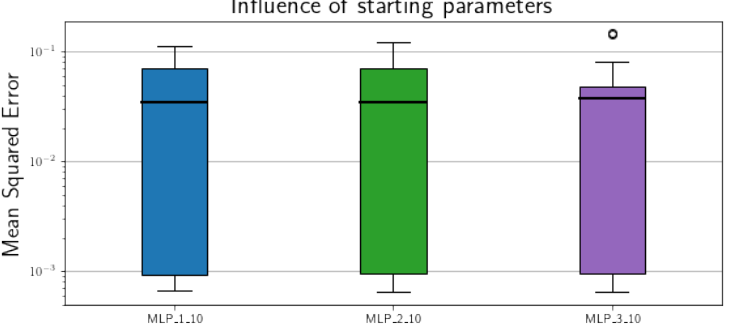
Figure 9. Limits and confidence intervals of the results of the MSE in the validation dataset after training MLP_1_10, MLP_2_10 and MLP_3_10_10 network architectures from 20 different random initial